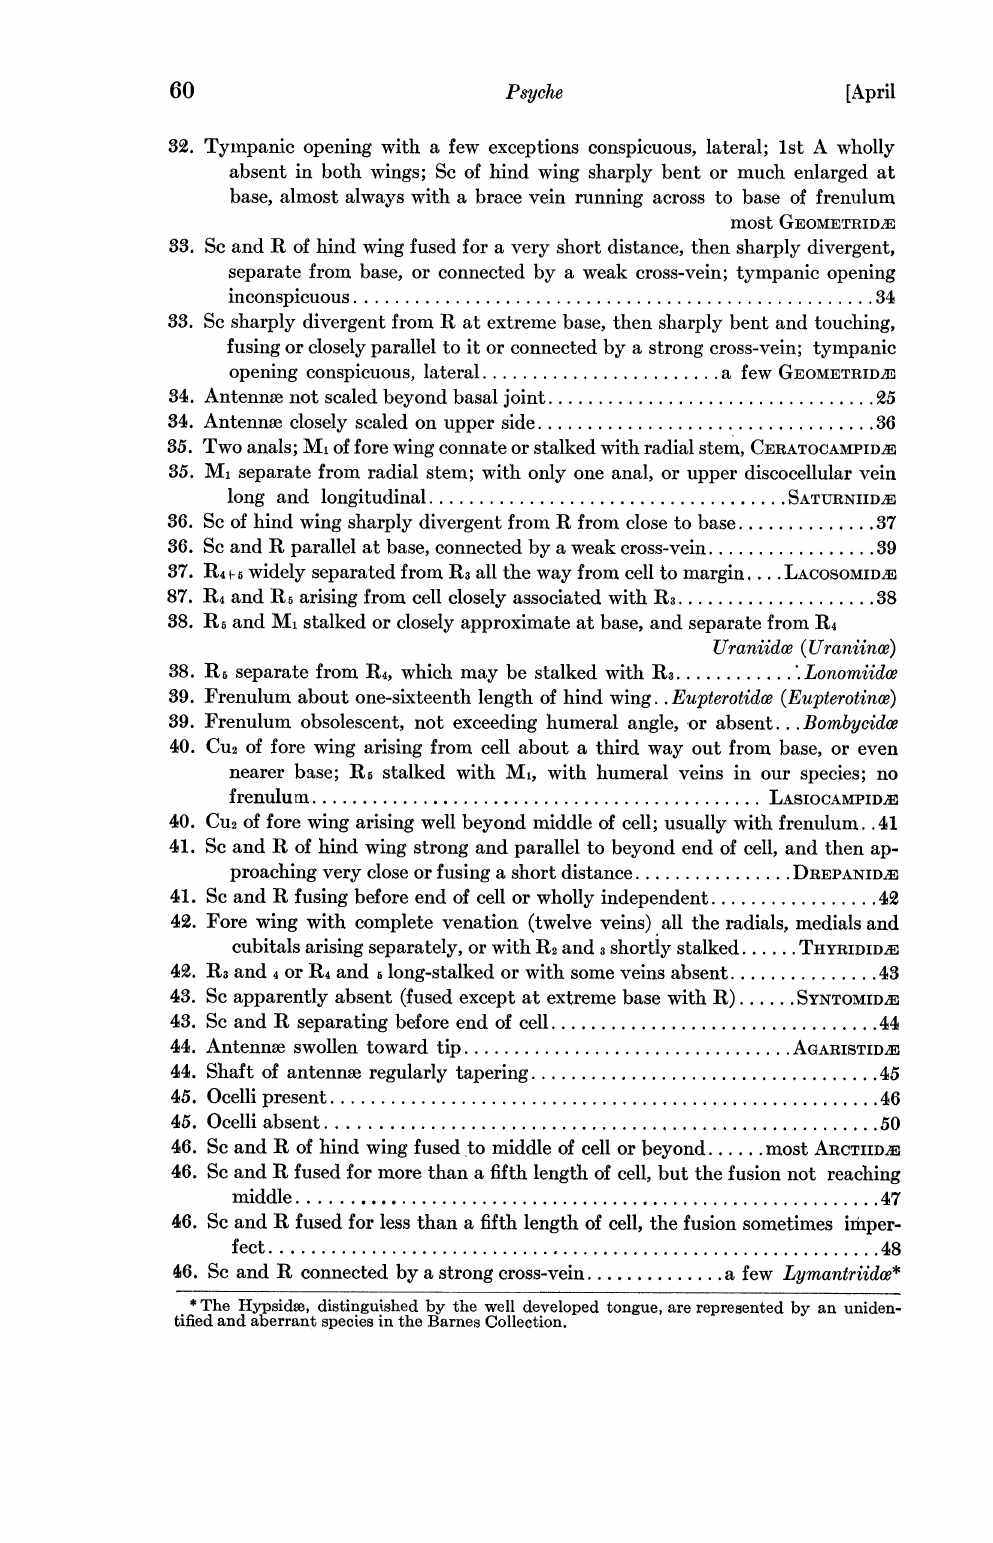
82. Tympanic opening with a few exceptions conspicuous, lateral; 1st A wholly absent in both wings; Sc of hind wing sharply bent or much enlarged at base, almost always with a brace vein running across to base of frenulum most GEOMETRIDE 33. Sc and R of hind wing fused for a very short distance, then sharply divergent, separate from base, or connected by a weak cross-vein; tympanic opening inconspicuous 34 83. Sc sharply divergent from R at extreme base, then sharply bent and touching, fusing or closely parallel to it or connected by a strong cross-vein; tympanic opening conspicuous, lateral a few GEOMETRIDE 34. Antennae not scaled beyond basal joint 5 84. Antennae closely scaled on upper side 86 85. Two anals; MI of fore wing connate or stalked with radial stem, CERATOCAMPID 35. M1 separate from radial stem; with only one anal, or upper discocellular vein long and longitudinal S&TURNIID 86. Sc of hind wing sharply divergent from R from close to base 37 36. Sc and R parallel at base, connected by a weak cross-vein 39 37. R4 widely separated from R3 all the way from cell to margin LXCOSOIDE 87. R4 and R5 arising from cell closely associated with R3 38 88. R and M stalked or closely approximate at base, and separate from R4 Uraniida Uraniine) 88. R5 separate from R4, which may be stalked with R3 :Lonomiidoe 89. Frenulum about one-sixteenth length of hind wing..Eupterotido (Eupterotine) 39. Frenulum obsolescent, not exceeding humeral angle, .or absent...Bombycido 40. Cu. of fore wing arising from cell about a third way out from base, or even nearer base; R stalked with M1, with humeral veins in our species; no frenulum LxsIocxPIDm 40. Cu2 of fore wing arising well beyond middle of cell; usually with frenulum.. 41 41. Sc and R of hind wing strong and parallel to beyond end of cell, and then ap- proaching very close or fusing a short distance DEPXDm 41. Sc and R fusing before end of cell or wholly independent 4 42. Fore wing with complete venation (twelve veins).all the radials, medials and cubitals arising separately, or with R2 and shortly stalked TVaDDm 4. Ra and, or R, and long-stalked or with some veins absent 43 43. Sc apparently absent (fused except at extreme base with